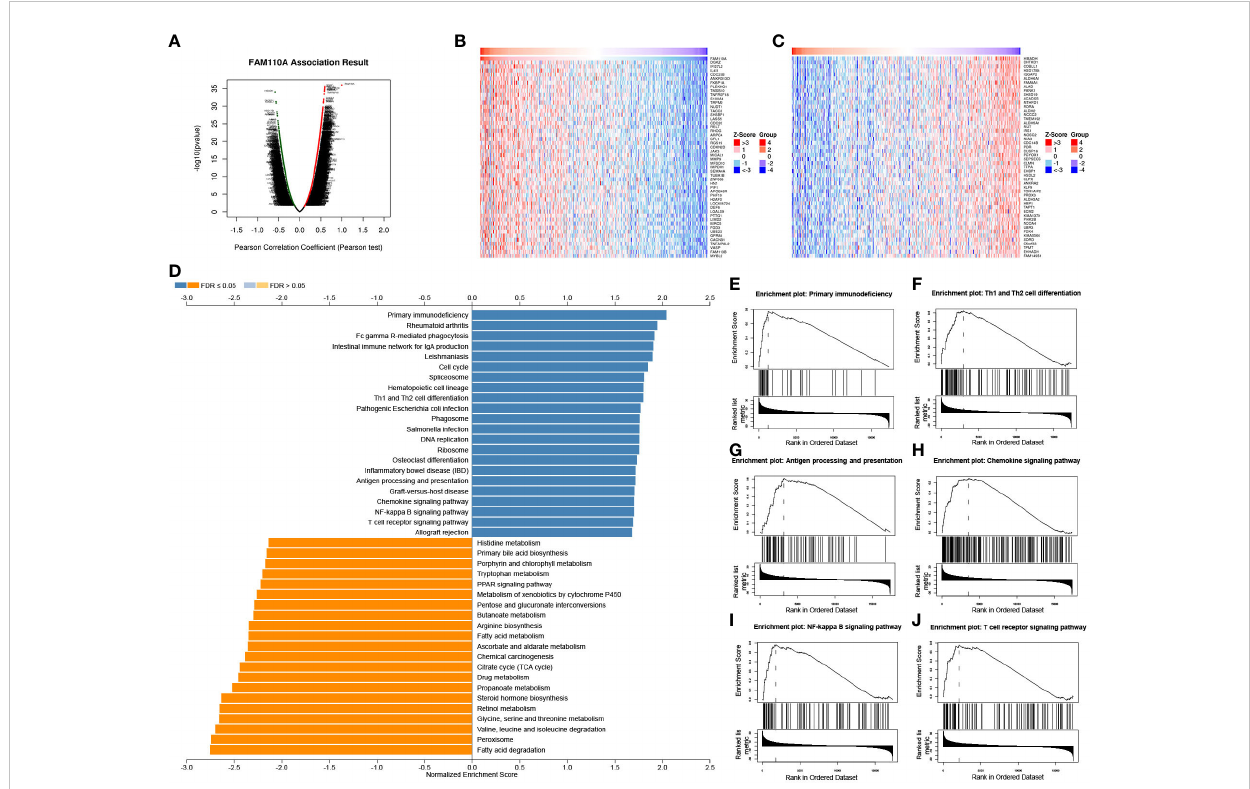
FIGURE 7 GSEA of FAM110A in the TCGA LIHC cohort. (A) Correlations between FAM110A and genes differentially expressed in LIHC. (B, C) Heat maps of the most 50 signi fi cant genes positively and negatively correlated with FAM110A in LIHC. (D-J) KEGG enrichment analyses showed that primary immunode fi ciency, Th1 and Th2 cell differentiation, antigen processing and presentation, chemokine signaling pathway, NF-kappa B signaling pathway, and T cell receptor signaling pathway were enriched.